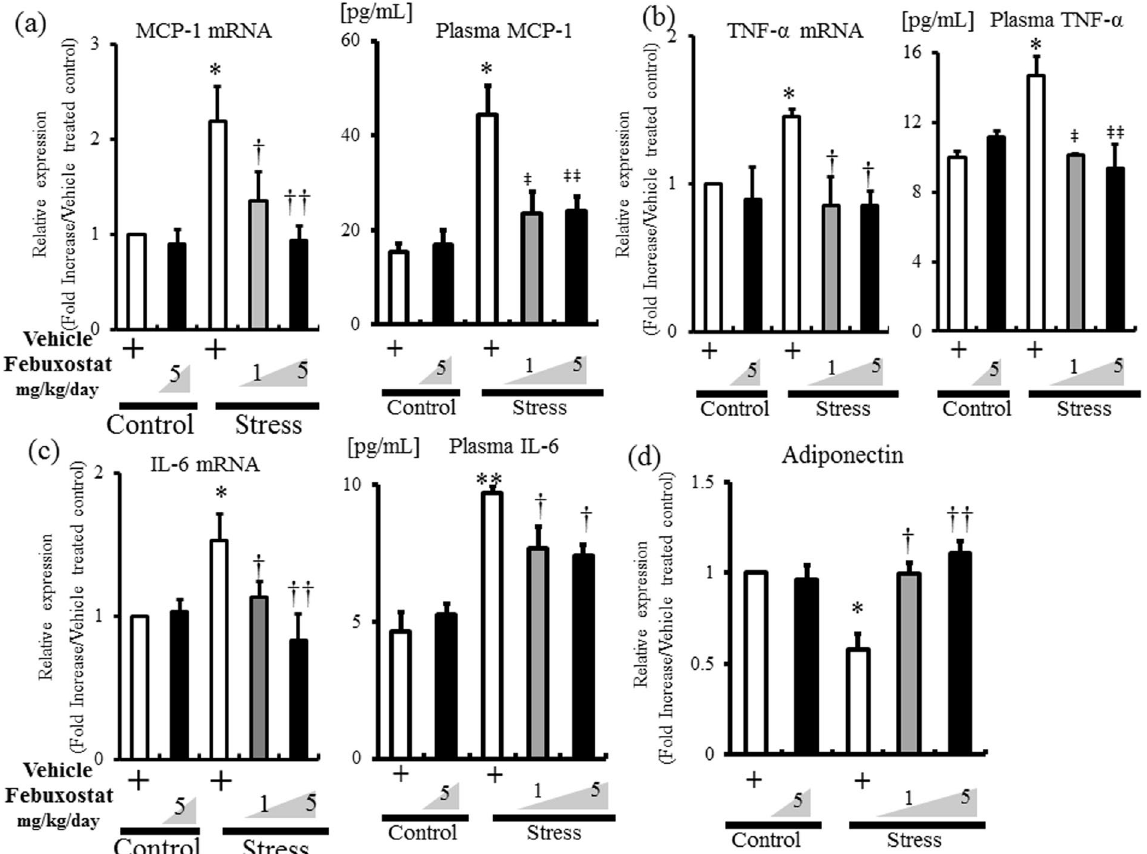
Figure 8. Febuxostat reduces the expression of stress-induced proinflammatory adipokines and restores adiponectin expression in adipose tissue. The mRNA expression levels of MCP-1 ( a ), TNF- α ( b ), IL-6 ( c ), and adiponectin ( d ) in inguinal adipose tissues of control mice treated with vehicle or febuxostat (5 mg/kg/day), and stressed mice treated with vehicle or febuxostat (1 or 5 mg/kg/day) were analyzed by quantitative RT-PCR. Values are expressed relative to the vehicle-treated control mice. Plasma concentrations of MCP-1, TNF- α and IL-6 ( a – c ), respectively) were also measured in the same groups. Data were analyzed by Student’s t-test and displayed as mean ± SD of 5–6 mice for RT-PCR and ELISA per group. ( a ) * P < 0.001, compared with the vehicle-treated control mice, † P < 0.03, †† P < 0.001, ‡ P < 0.003 and ‡‡ P < 0.002, compared with the vehicle- treated stressed mice, respectively. ( b ) * P < 0.01, compared with the vehicle-treated control mice, † P < 0.001, ‡ P < 0.02 and ‡‡ P < 0.002, compared with the vehicle-treated stressed mice, respectively. ( c ) * P < 0.005 and ** P < 0.001, compared with the vehicle-treated control mice, † P < 0.02, and †† P < 0.001, compared with the vehicle-treated stressed mice, respectively. ( d ) * P < 0.005, compared with the vehicle-treated control mice, † P < 0.02, and †† P < 0.01, compared with the vehicle-treated stressed mice,